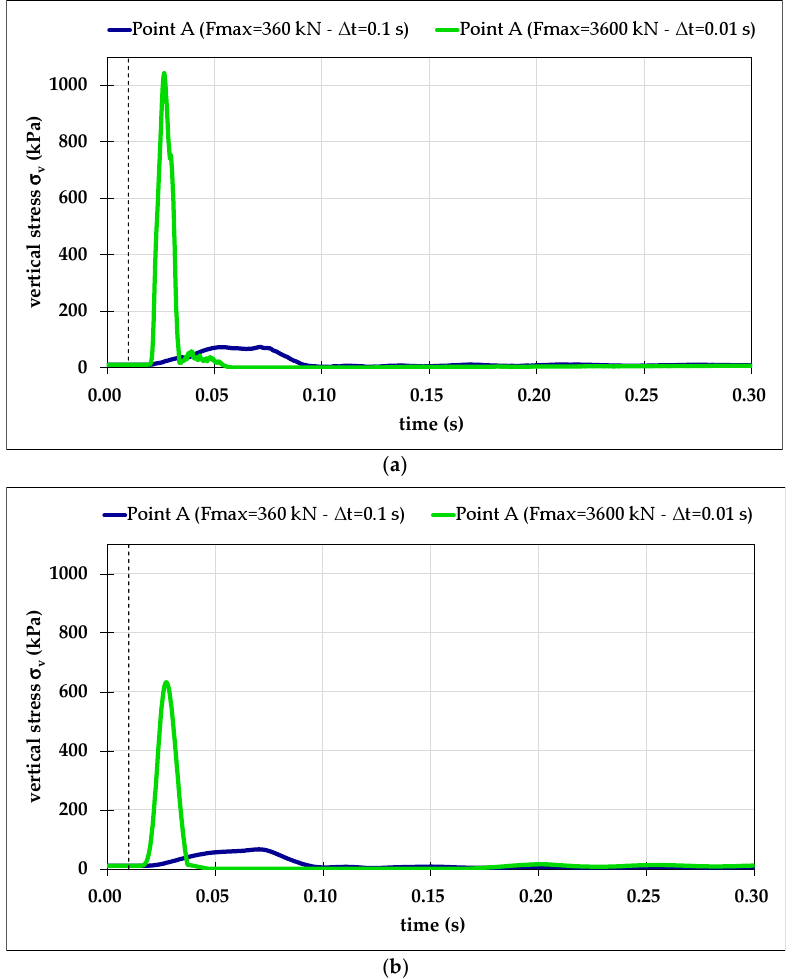
Figure 7. Vertical stress with time at a depth of about 4.5 m, along the loading vertical, for the two options of collision time, without ( a ) and with ( b ) damping. Young modulus for this analysis: 33 MPa. The vertical dashed line indicates the start of the impulse load.